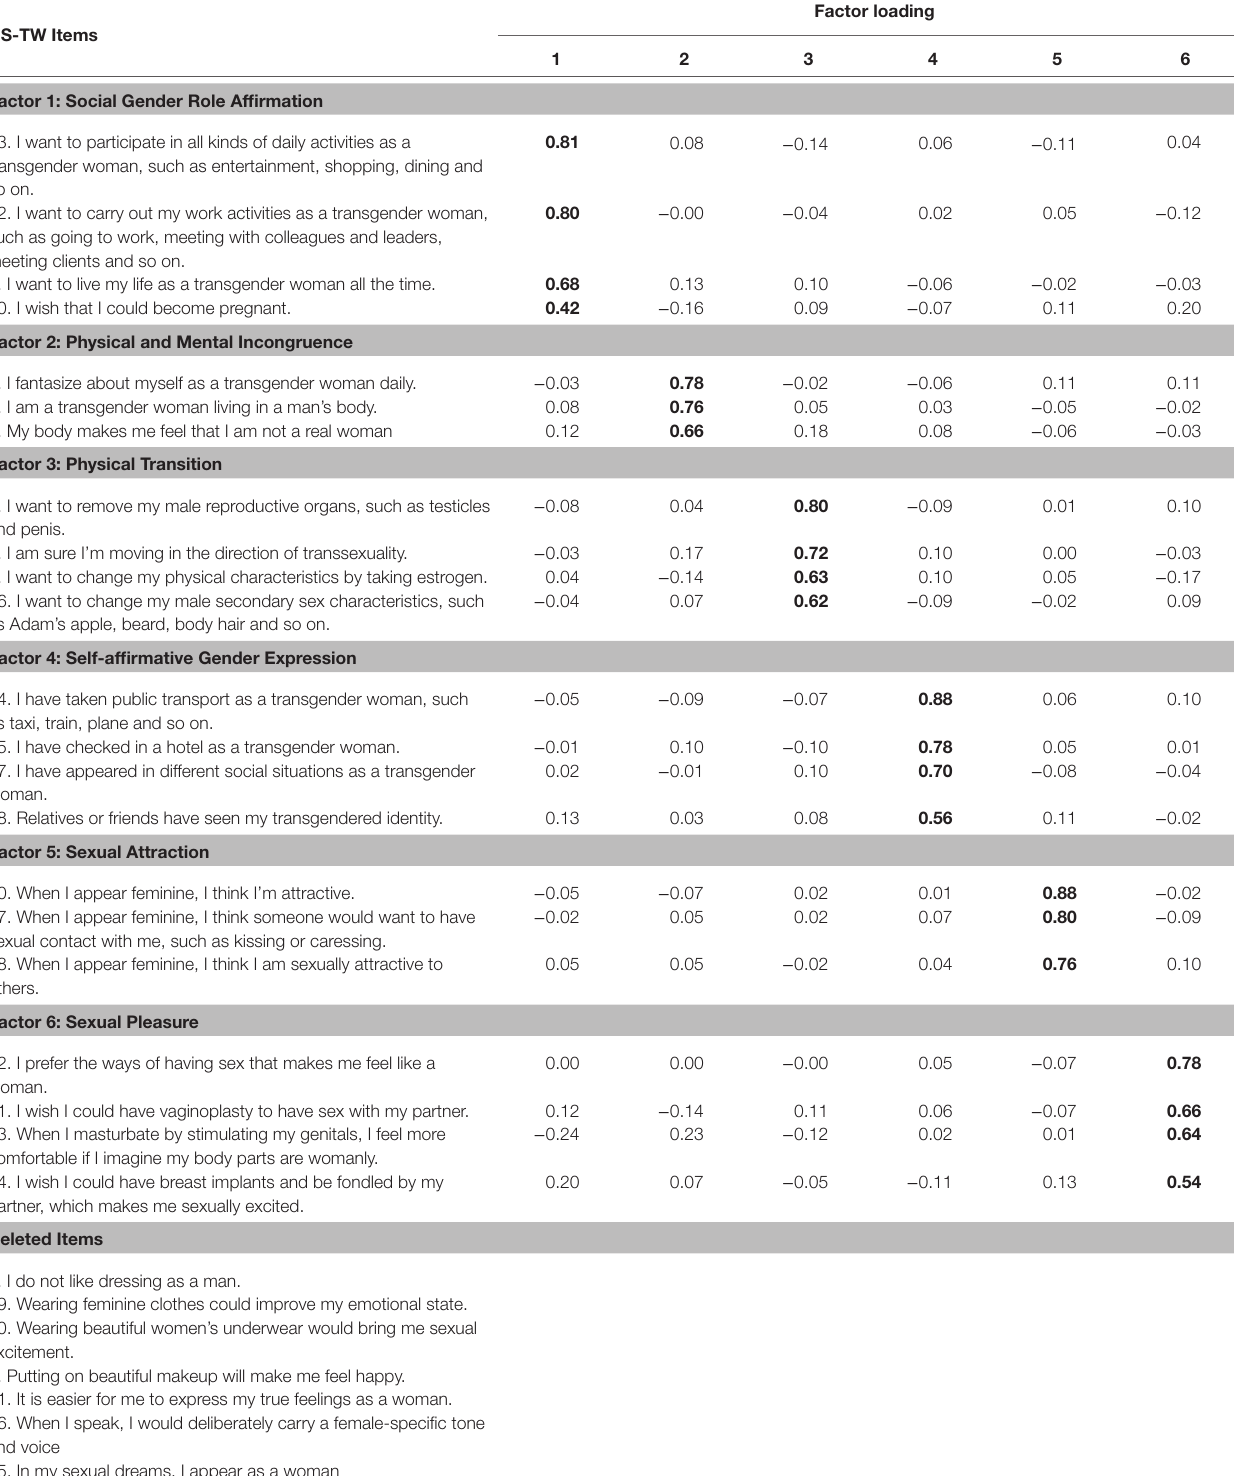
TABLE 2 | Exploratory factor analysis of the gender identity scale for transgender women.